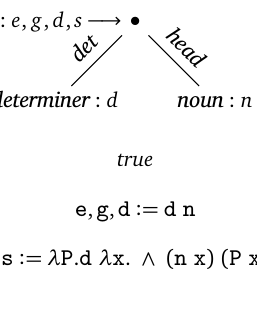
Figure 18: Second part of the full synchronous grammar, with logical constraints and